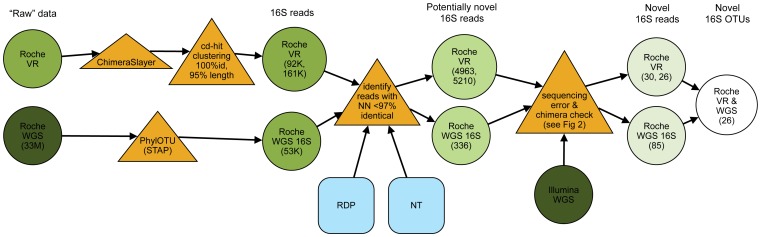
Flow chart describing the pipeline for the identification of novel OTUs.Green circles represent the data collected by the HMP, with the darkest green circles representing WGS read, and successively lighter green circles associated with 16S reads that show progressively more evidence of novelty. Blue squares represent external databases used to determine novelty. Major filtering steps in the pipeline are shown as yellow triangles.